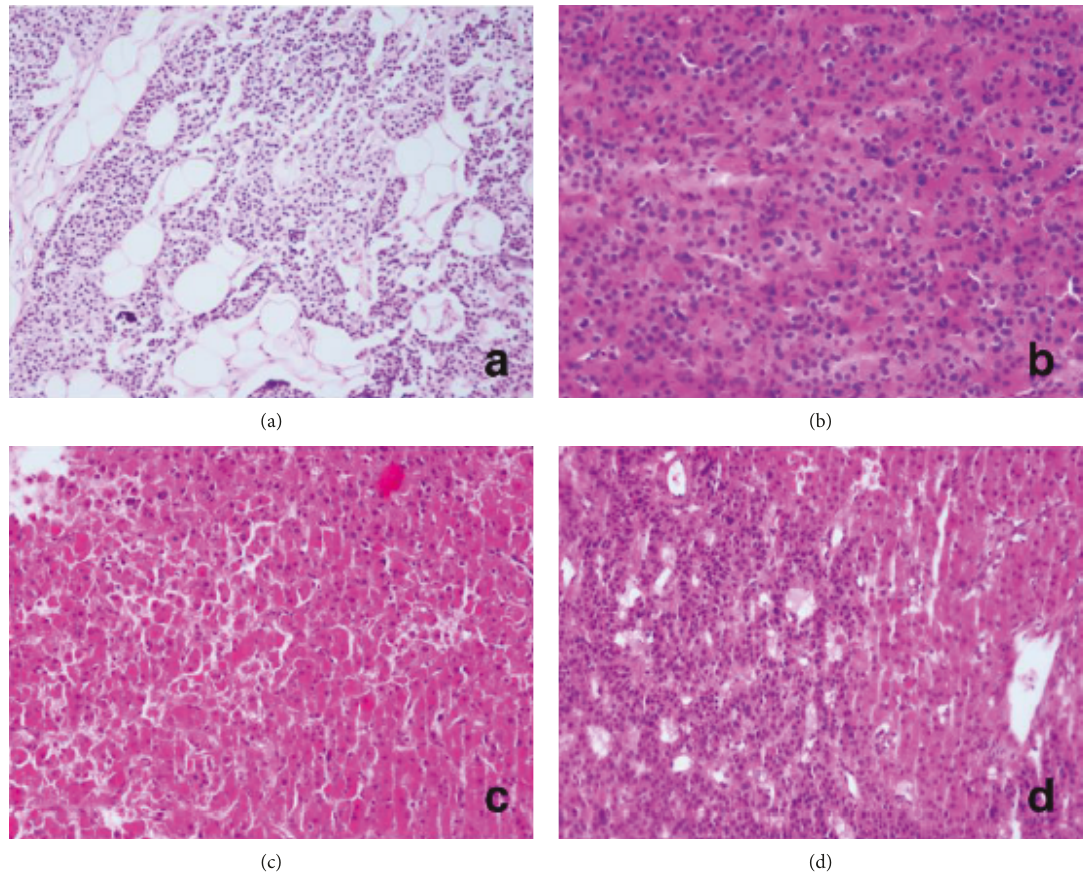
Figure 2: Microscopic fi nding from the parathyroid glands. (a) Right inferior paratiroid hyperplasia (H&E stain). (b) Right superior paratiroid hyperplasia (H&E stain). (c) Left inferior paratiroid hyperplasia (H&E stain). (d) Left superior paratiroid hyperplasia (H&E